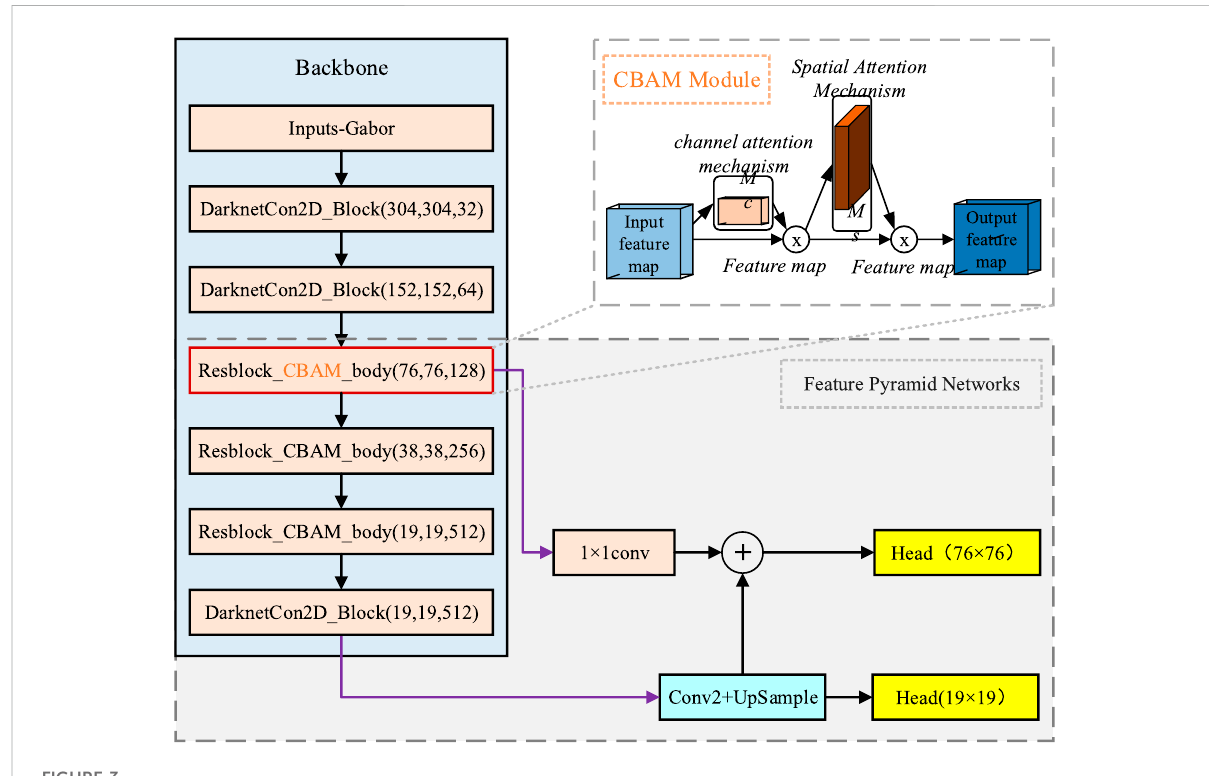
FIGURE 3 Improved YOLO Network based on the Gabor